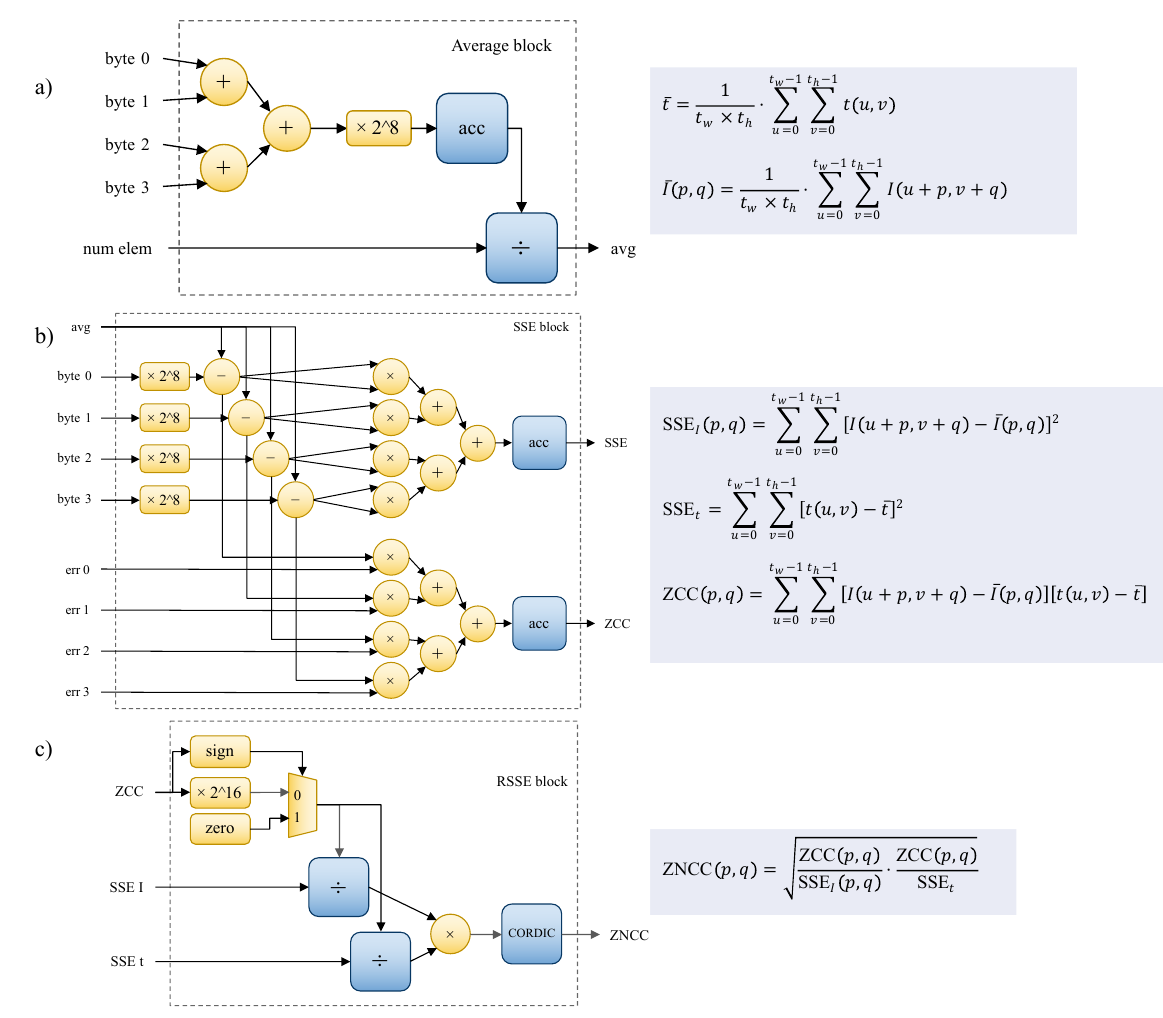
Figure 6. This figure shows how the elemental blocks of the datapath are built from available soft IP cores and basic low-level and logic arithmetic blocks, each of which is implemented using the programmable fabric of the FPGA. ( a ) The average block; ( b ) the SSE block; ( c ) the RSSE block. The RSSE block (Figure 6c) design process required a top-down approach.